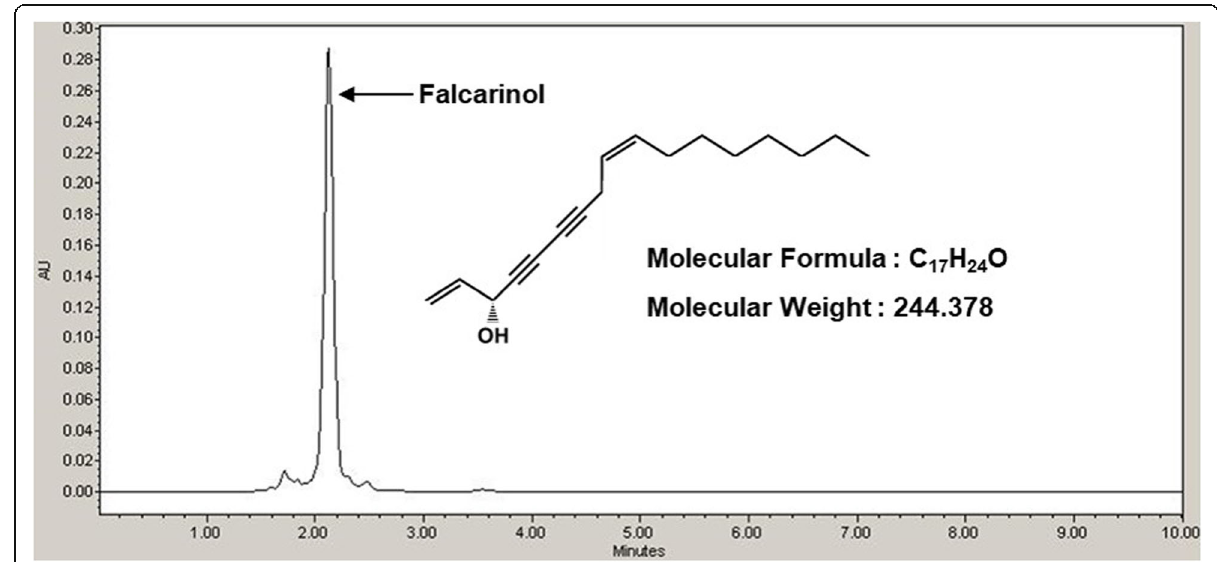
Fig. 5 Chromatography of HPLC analysis of